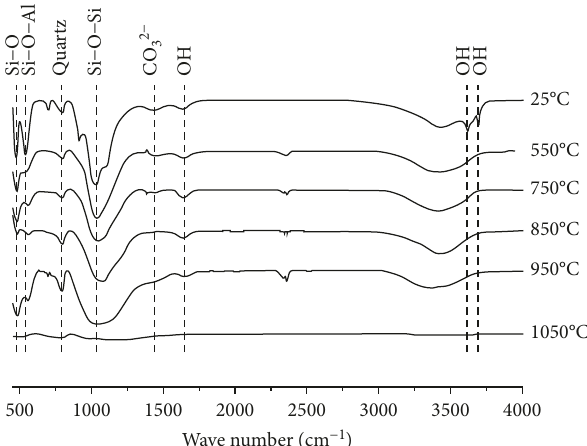
Figure 3: Fourier transform infrared (FTIR) spectra of raw and calcined